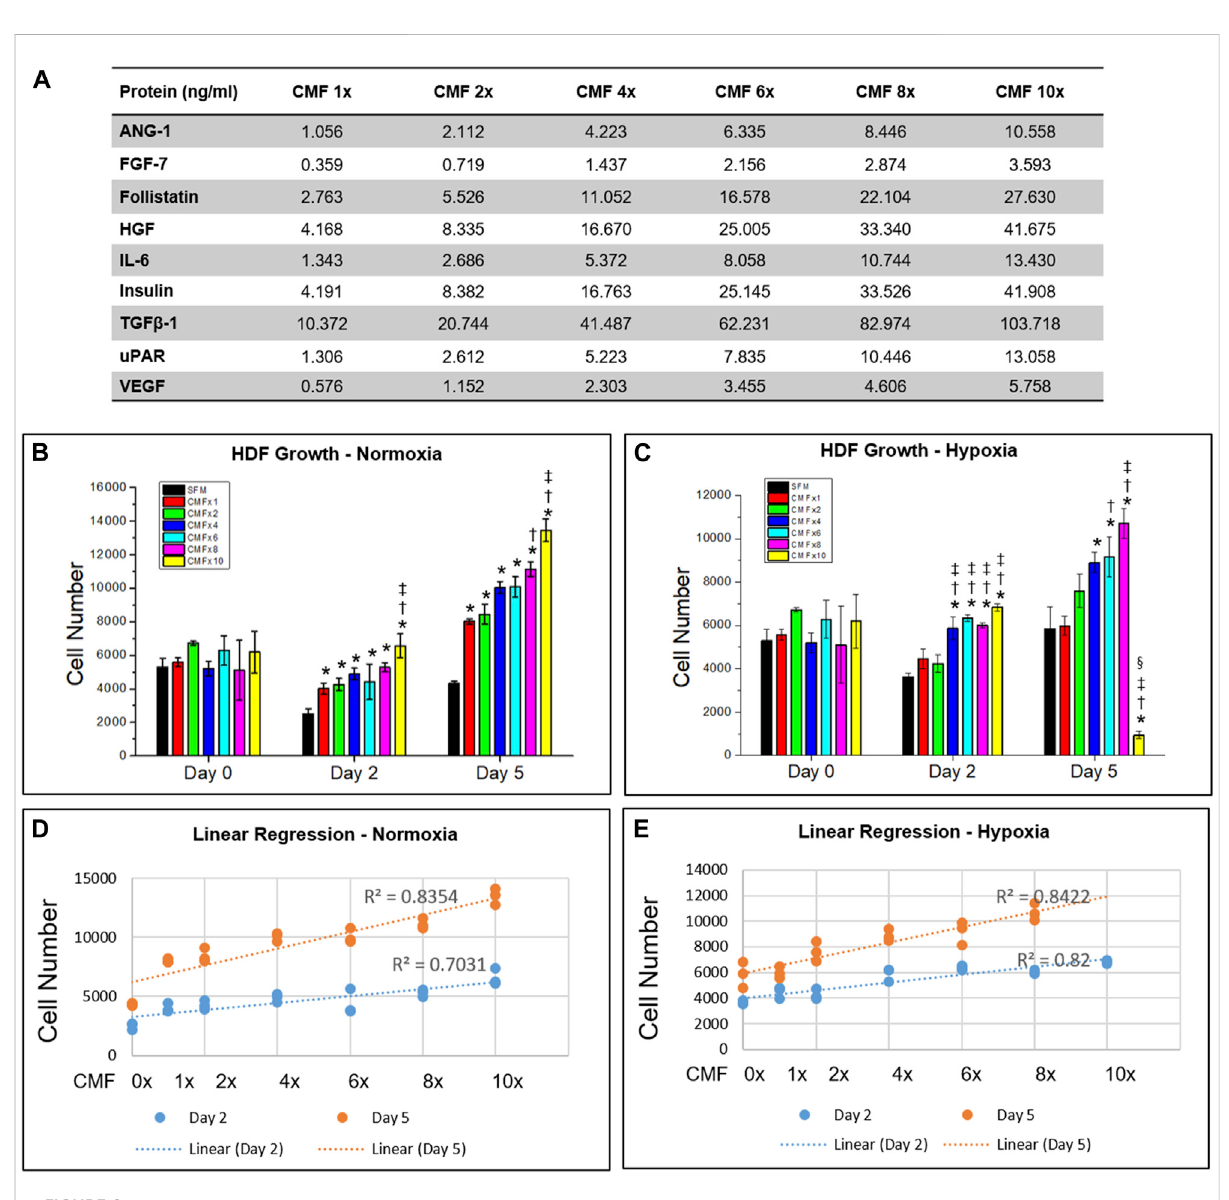
FIGURE 2 Optimization of CMF concentration. Human dermal fi broblasts (HDF) are treated with SFM (CMF 0×) and various CMF (nine protein combination: ANG-1, FGF-7, Follistatin, HGF, IL-6, Insulin, TGF β -1, uPAR, and VEGF) concentrations (CMF 1×, 2×, 4×, 6×, 8×, and 10×) (A) , and cell growth is measured using Alamar Blue assay. (B,C) Cell number cultured in normoxia (B) and hypoxia (C) . (D,E) Linear regression relation between CMF concentration and cell number in normoxia (D) and hypoxia (E) . In hypoxia, CMF 10× data is excluded. The results indicate that CMF increases cell growth in a dose-dependent manner but not in concentrations greater than 6×. Overall, CMF at a concentration of 6× is the optimal concentration to enhance HDF growth ( n = 3, duplicate measure, two-way ANOVA and Tukey ’ s test, (B) * p < 0.05 with SFM, † p < 0.05 with CMF 1×, ‡ p < 0.05 with CMF2×,4×, and6×, NS: p > 0.05, (C) * p < 0.05with SFM. † p < 0.05with CMF 1×. ‡ p < 0.05with CMF2×, § p < 0.05 with CMF4×,6×, and 8×, NS: p >